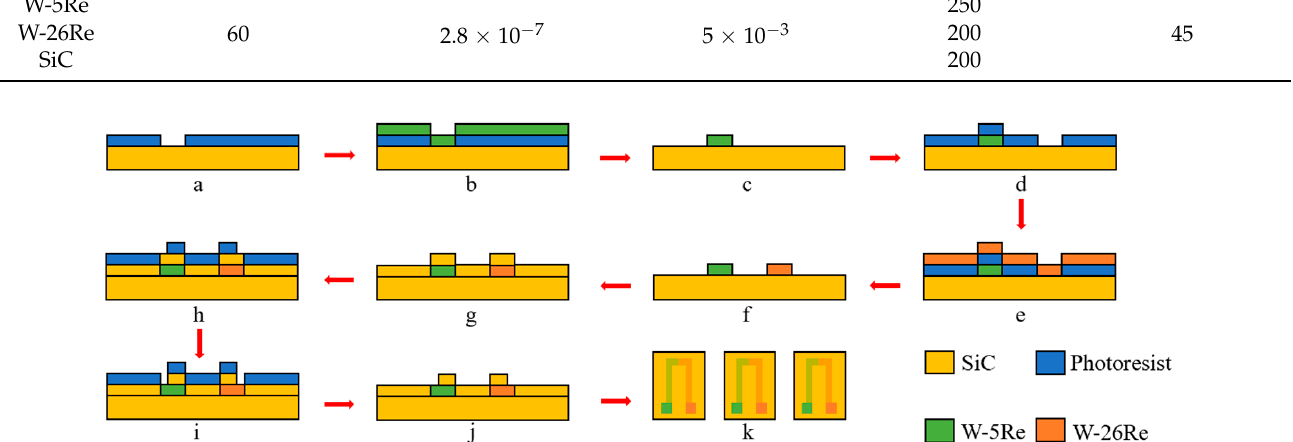
Figure 1. Fabrication process of tungsten-rhenium TFTCs ( a – k ).